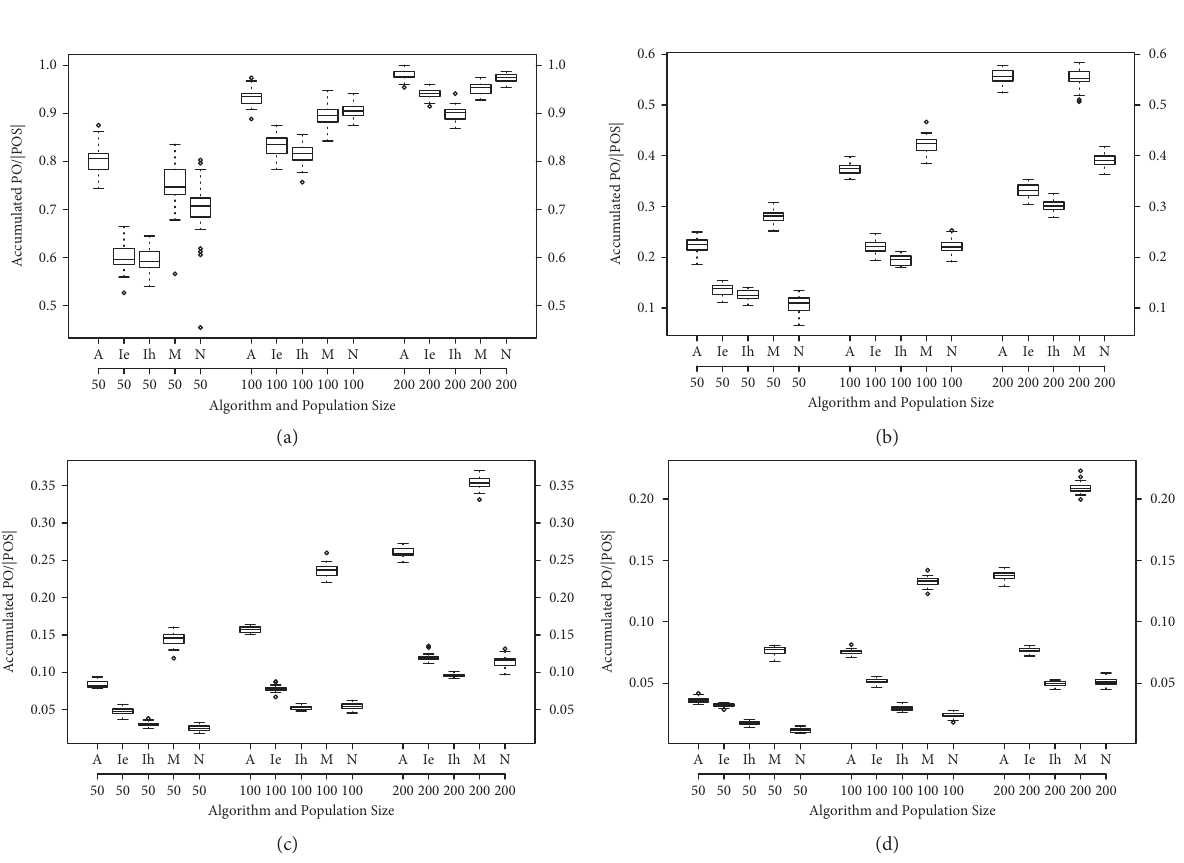
Figure 1: Resolution of the approximation at the end of the run α ( T ) , that is, ratio of the accumulated number of Pareto optimal solutions found to the size of the POS. Population sizes 50, 100, and 200 for 3, 4, 5, and 6 objectives. Algorithms A ϵ S ϵ H ( A ) , IBEA NSGA-II ( N ), and MOEA/D ( M ). (a) M � 3 objectives, (b) M � 4 objectives, (c) M � 5 objectives, and (d) M � 6